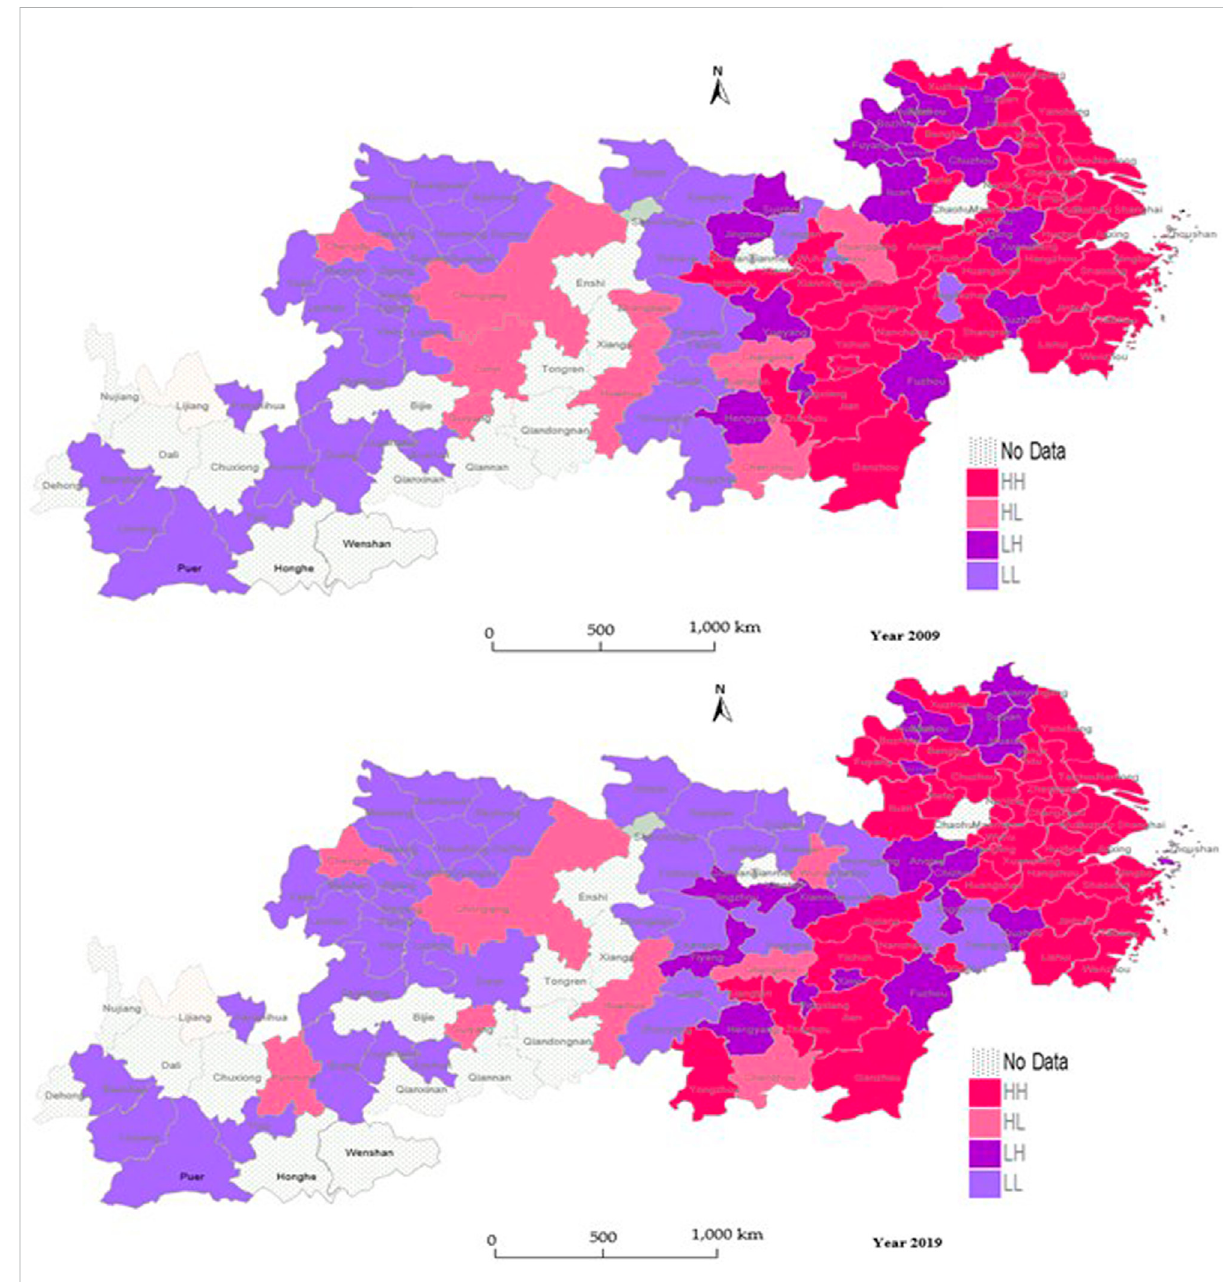
FIGURE 8 Local spatial correlation diagram of coupling degree between the USFD and green economic development in the YREB in 2009 and